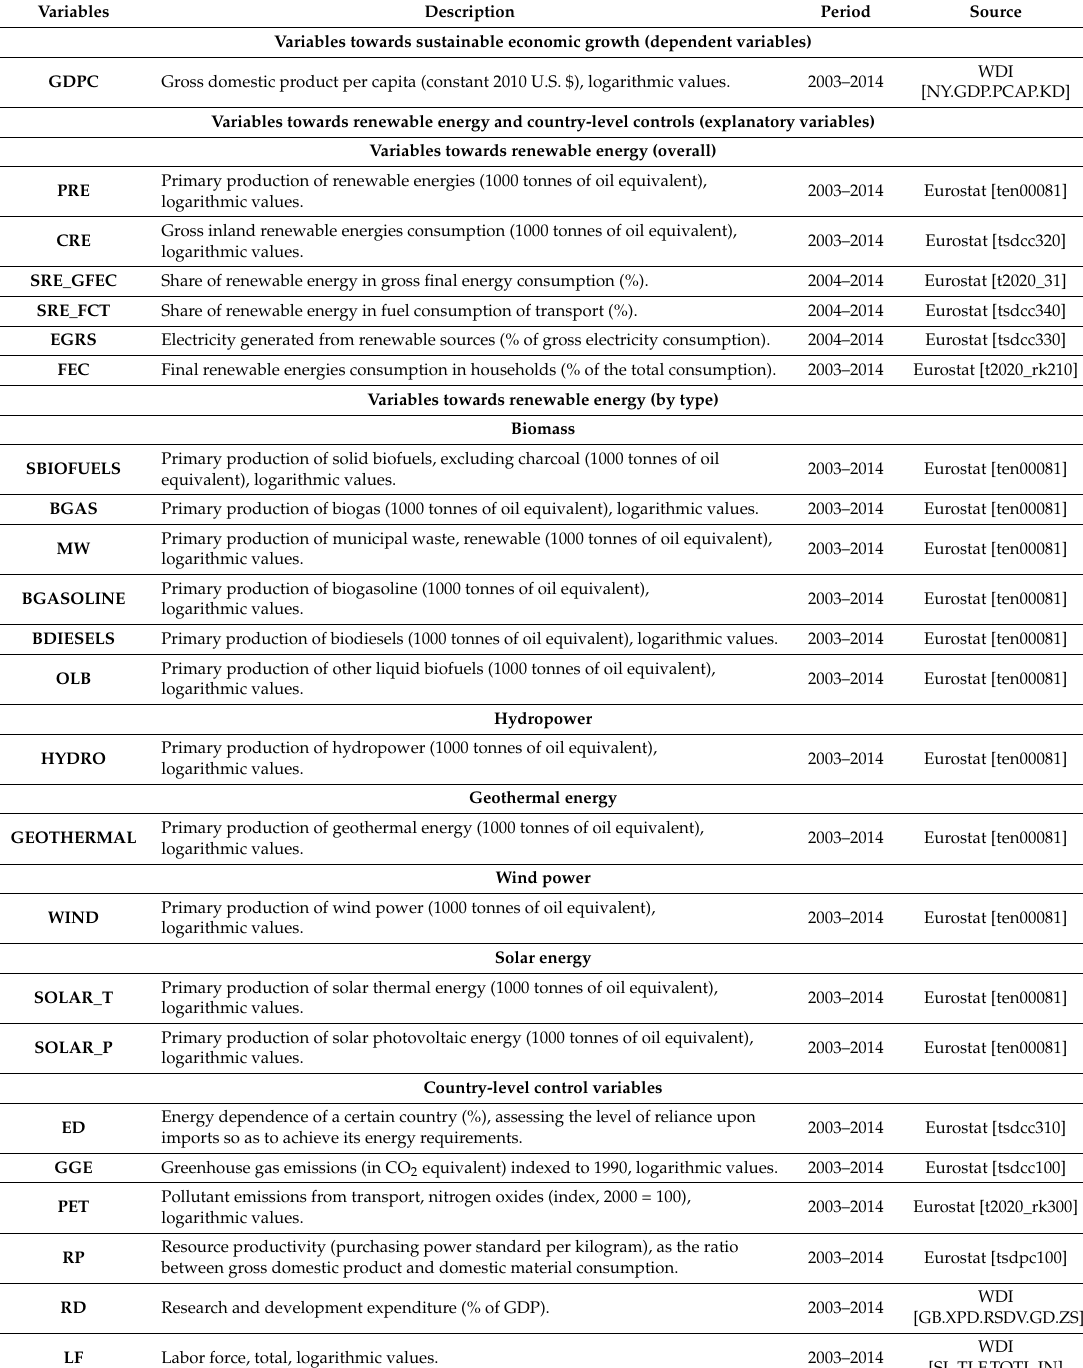
Table 2. Exhibition of the